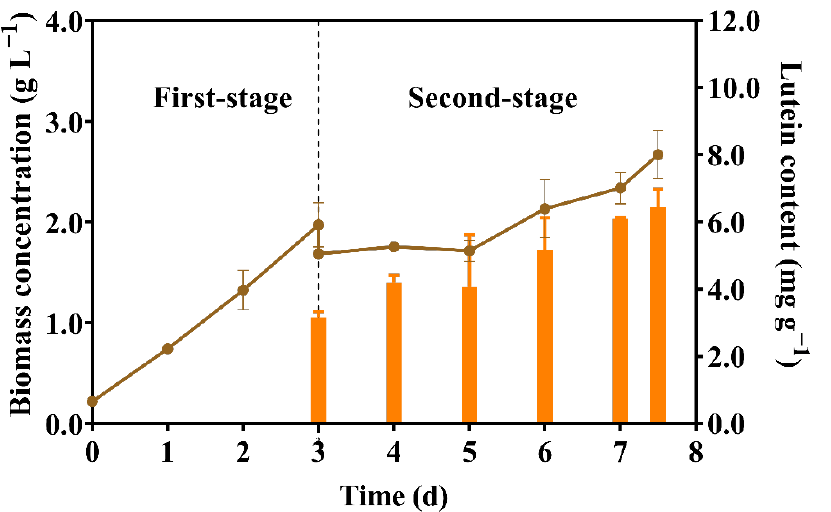
Figure 5. Growth and lutein content for Scenedesmus sp. FSP3 using two-stage culture under optimized conditions. In the first stage, Scenedesmus sp. FSP3 were cultured with added PC and 5% CO 2 , aerated for 3 days. For the second stage, they were cultured under a light intensity of 160 μmol m −2 s −1 and an NaCl concentration of 156.6 mmol L −1 for 4.5 days.